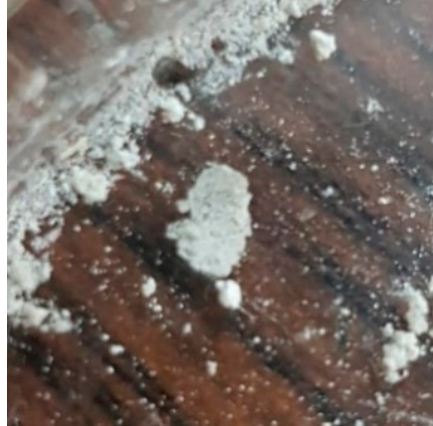
Figure 9. Brittle and Fragile film of extracted polymer.